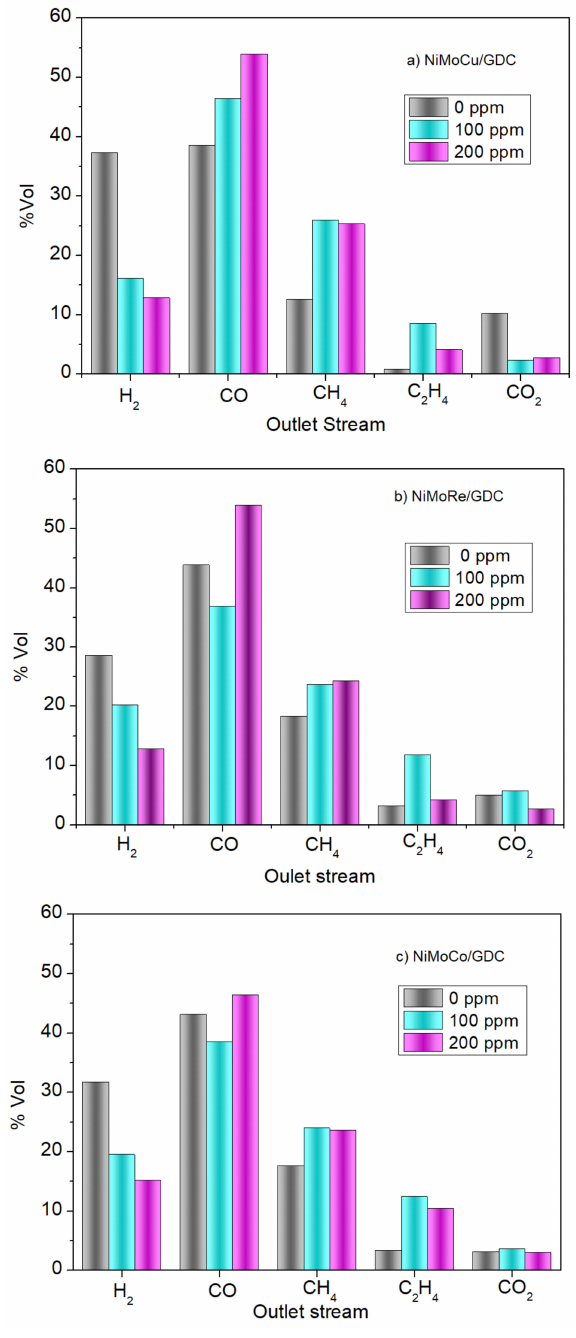
Figure 10. Sulfur impact on products distribution of auto-thermal reforming catalyzed by: ( a ) NiMoCu/GDC, ( b ) NiMoRe/GDC, ( c ) NiMoCo/GDC, (800 ◦ C, 10 h, 120,000 h − 1 space